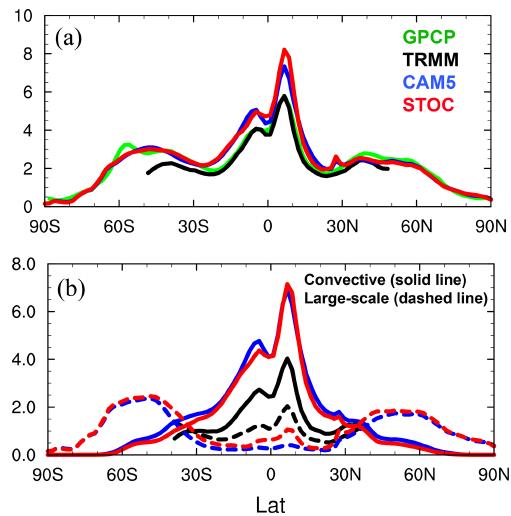
Figure 1. Zonal mean (a) total (solid line), (b) convective (solid line) and large-scale (dashed line) precipitation in CAM5 (blue), STOC (red) and TRMM (black). Zonal mean total rain in GPCP (green) is also